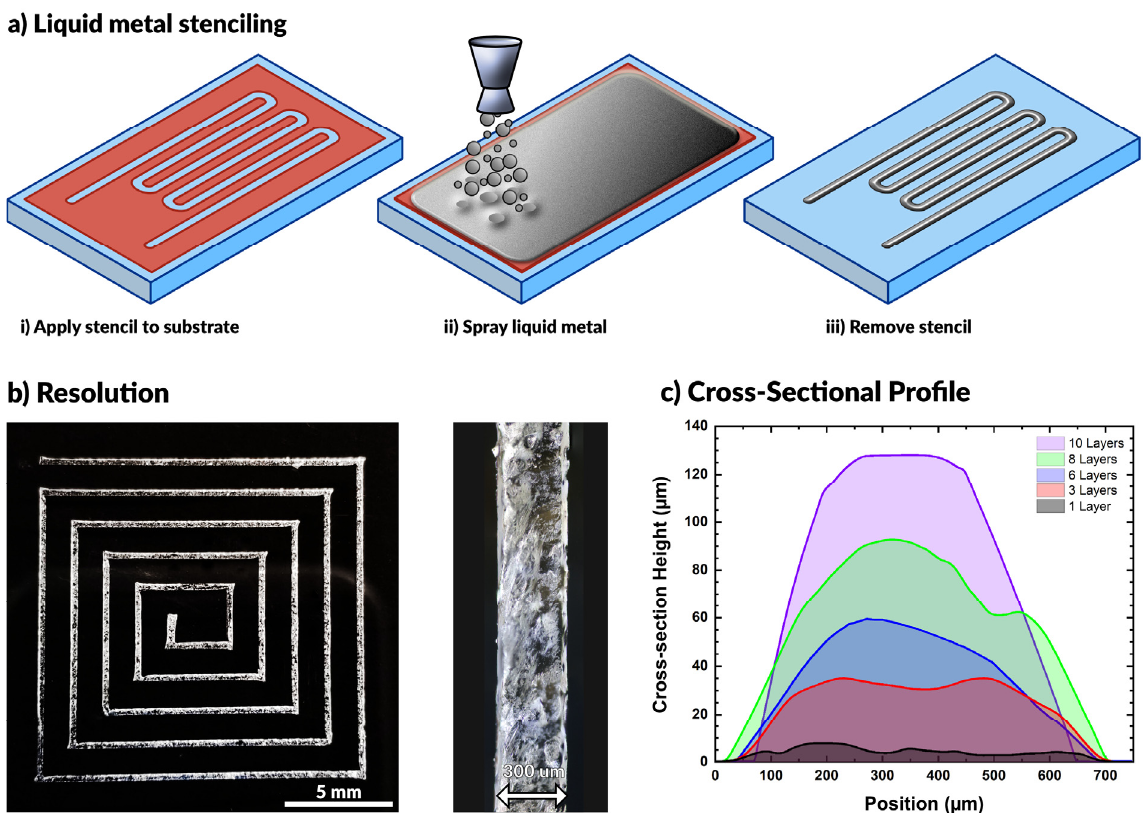
Figure 1. ( a ) Schematic depiction of the aerosol spraying process for liquid metals. Vinyl stencils conform to the substrate, the airbrush sprays liquid metal across the surface, and removal of the stencil produces a pattern. ( b ) A square spiral patterned by spraying liquid metal with 300 µ m wide lines. ( c ) Cross-sectional profile of liquid metal lines after multiple coatings.